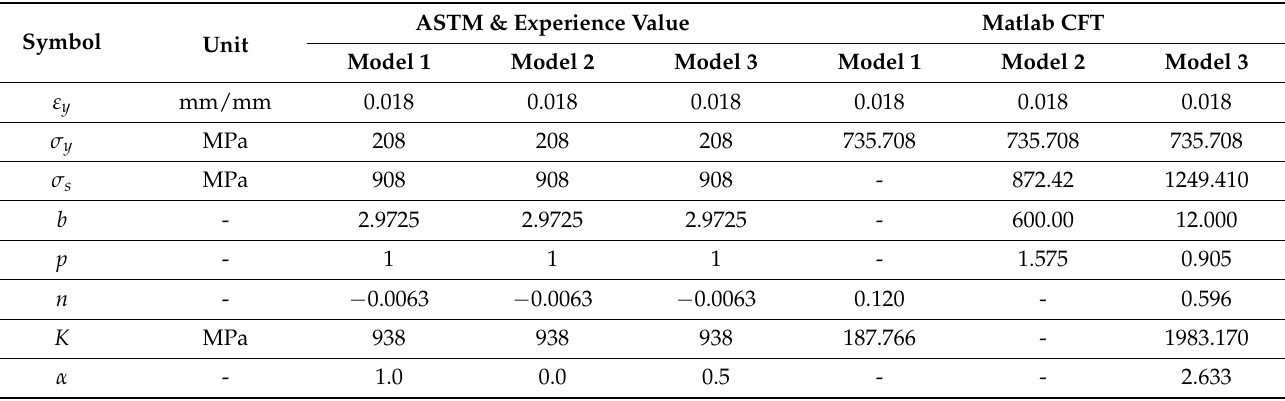
Figure 7. FE simulation procedures: ( a ) method that initializes the parameter once; ( b ) method that applies CFT. Table 3. Definition of parameter for constitutive model.